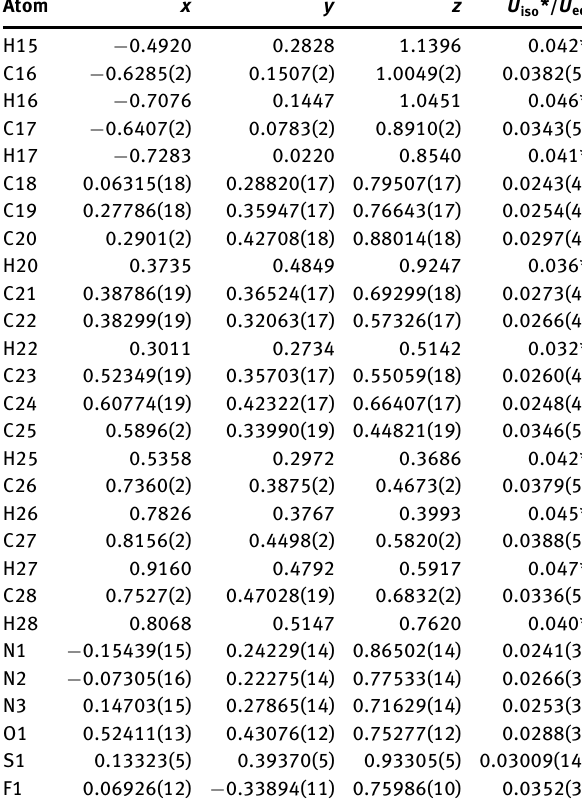
C—H· · · N = 170.8°. The benzofuran groups of neighbouring molecules are involved in π-π interaction with a centroid-to- centroid distance of 3.69